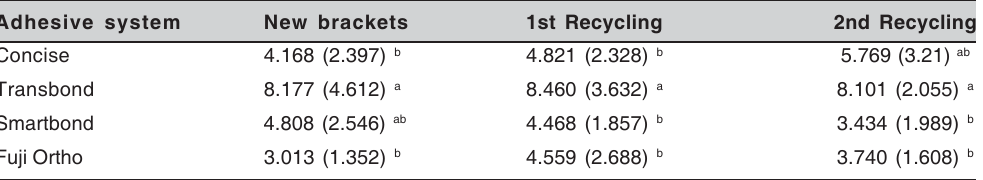
Different letters indicate statistically significant difference within and among materials at each debonding sequence ( p